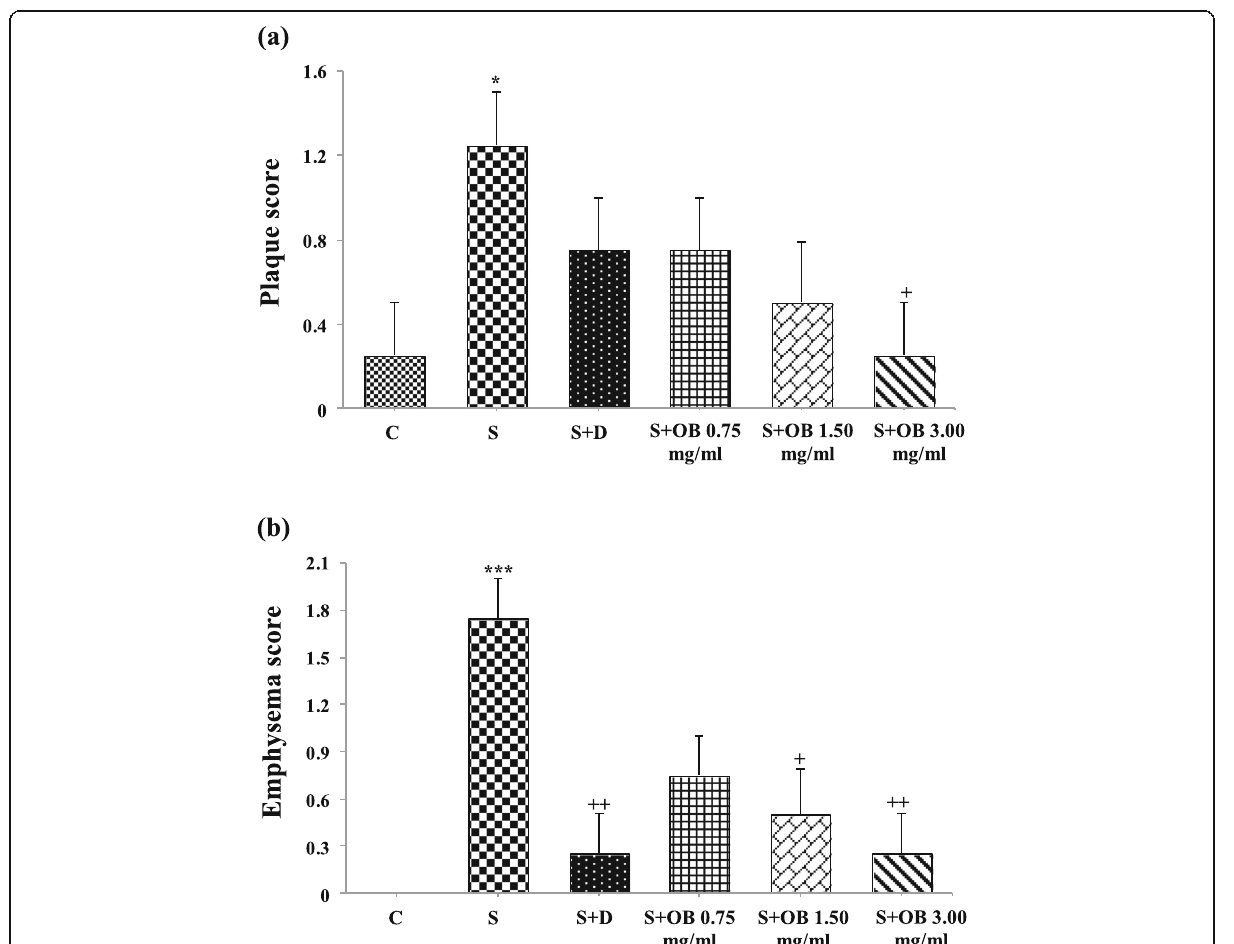
Fig. 8 The score of airway plaque ( a ) and emphysema ( b ) in the control (C), sensitized (S), treated sensitized animals with dexamethasone (S + D) and three O. basilicum concentrations (S + OB) groups, (in each group, n = 8). *: p < 0.05, ***: p < 0.001, comparison with C group. +: p < 0. 05, ++: p < 0.01, comparison with S group. One-way analysis of variance (ANOVA) with Tukey-Kramer ’ s post-test was used for statistical analysis